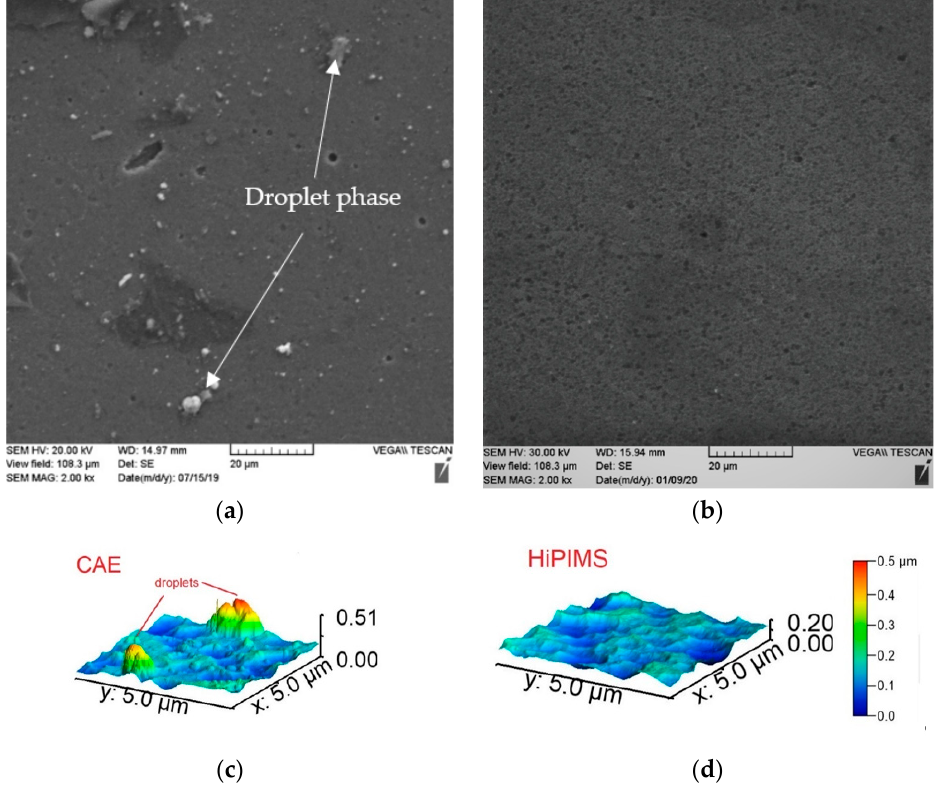
Figure 1. SEM/AFM data on the surface morphology: ( a ) CAD; ( b ) HiPIMS coatings: SEM data; ( c ) CAD; ( d ) HiPIMS: AFM data.